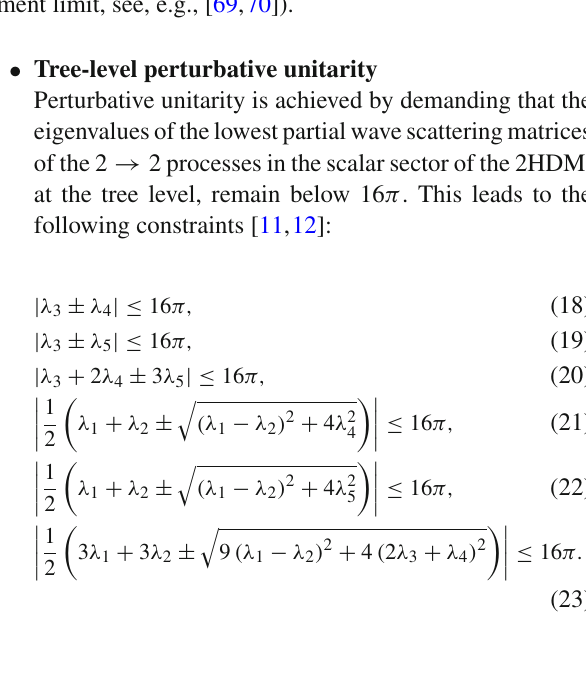
[67,68], relative (left) and absolute (right) hhh